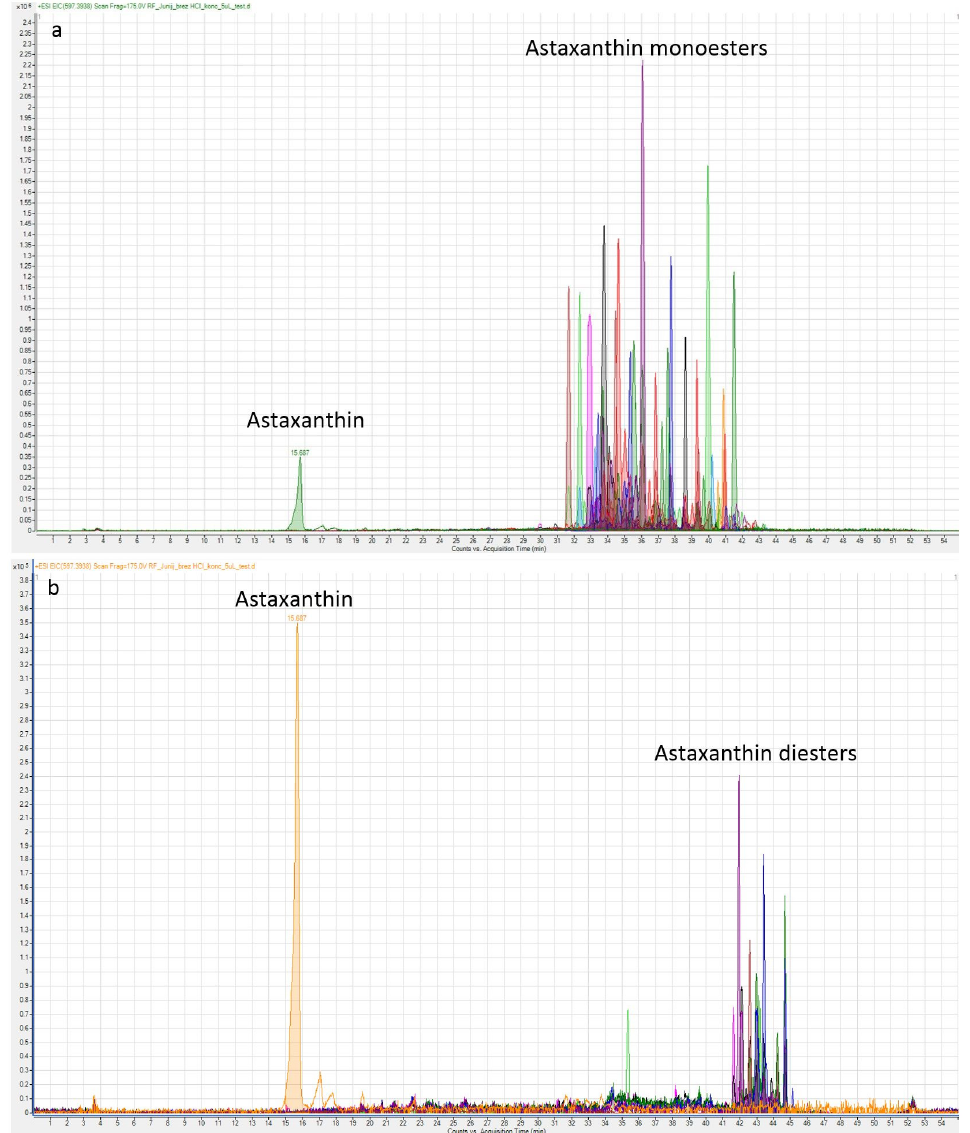
Figure 3. LC-QTOF-MS chromatograms, astaxanthin, ( a ), monoesters and ( b ), diesters.